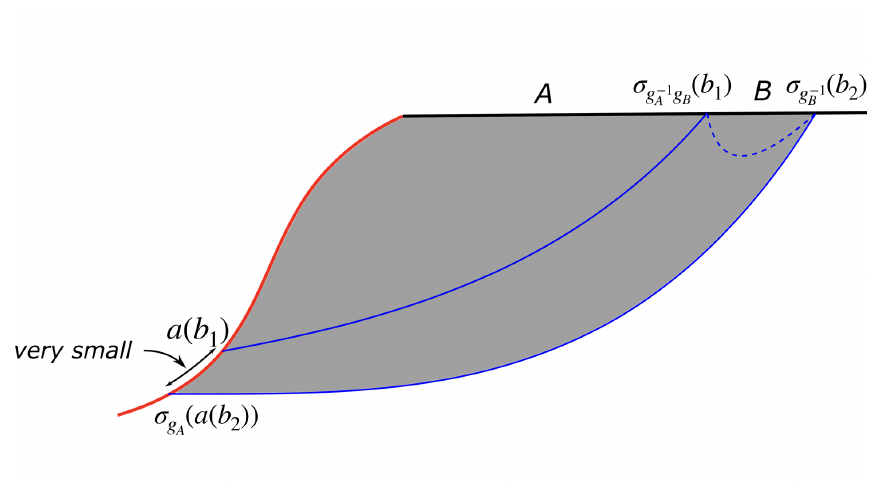
Figure 16: Schematic of the island proposal-II for the entanglement negativity of the mixed state configuration of the adjacent intervals in phase-II. The emergent twist operators required for the computation of the reflected entropy are depicted. Figure modified from [ 68